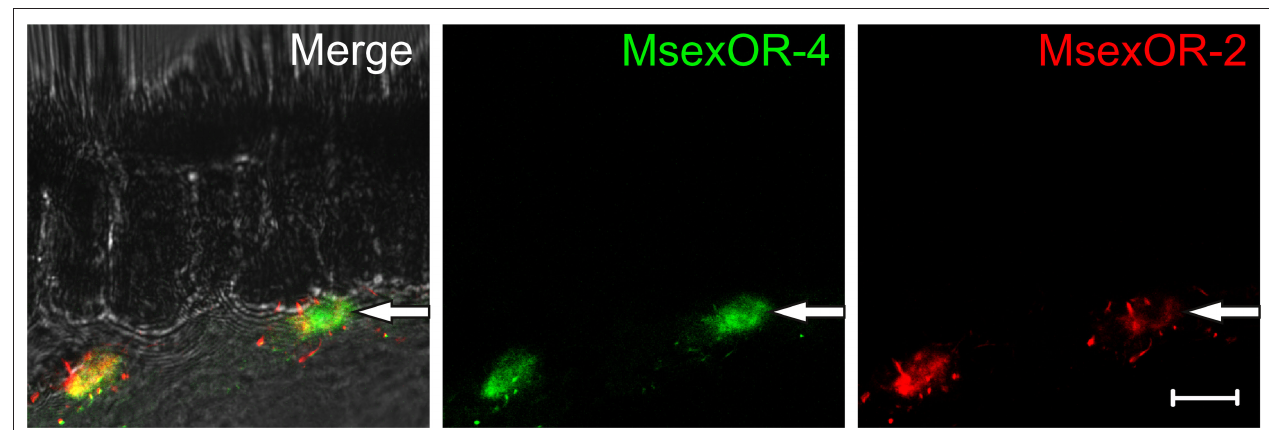
single optical slice of a confocal stack. In close proximity to sensilla trichodea, probes label the same cells. While in some cases a clear double labeling is not apparent (arrow), close scrutiny reveals a weak red staining. (Scale bar = 10